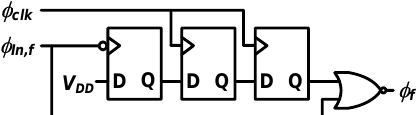
Figure 7. Structure of the time splitter (reproduced from [18] with permission from the IEEE).